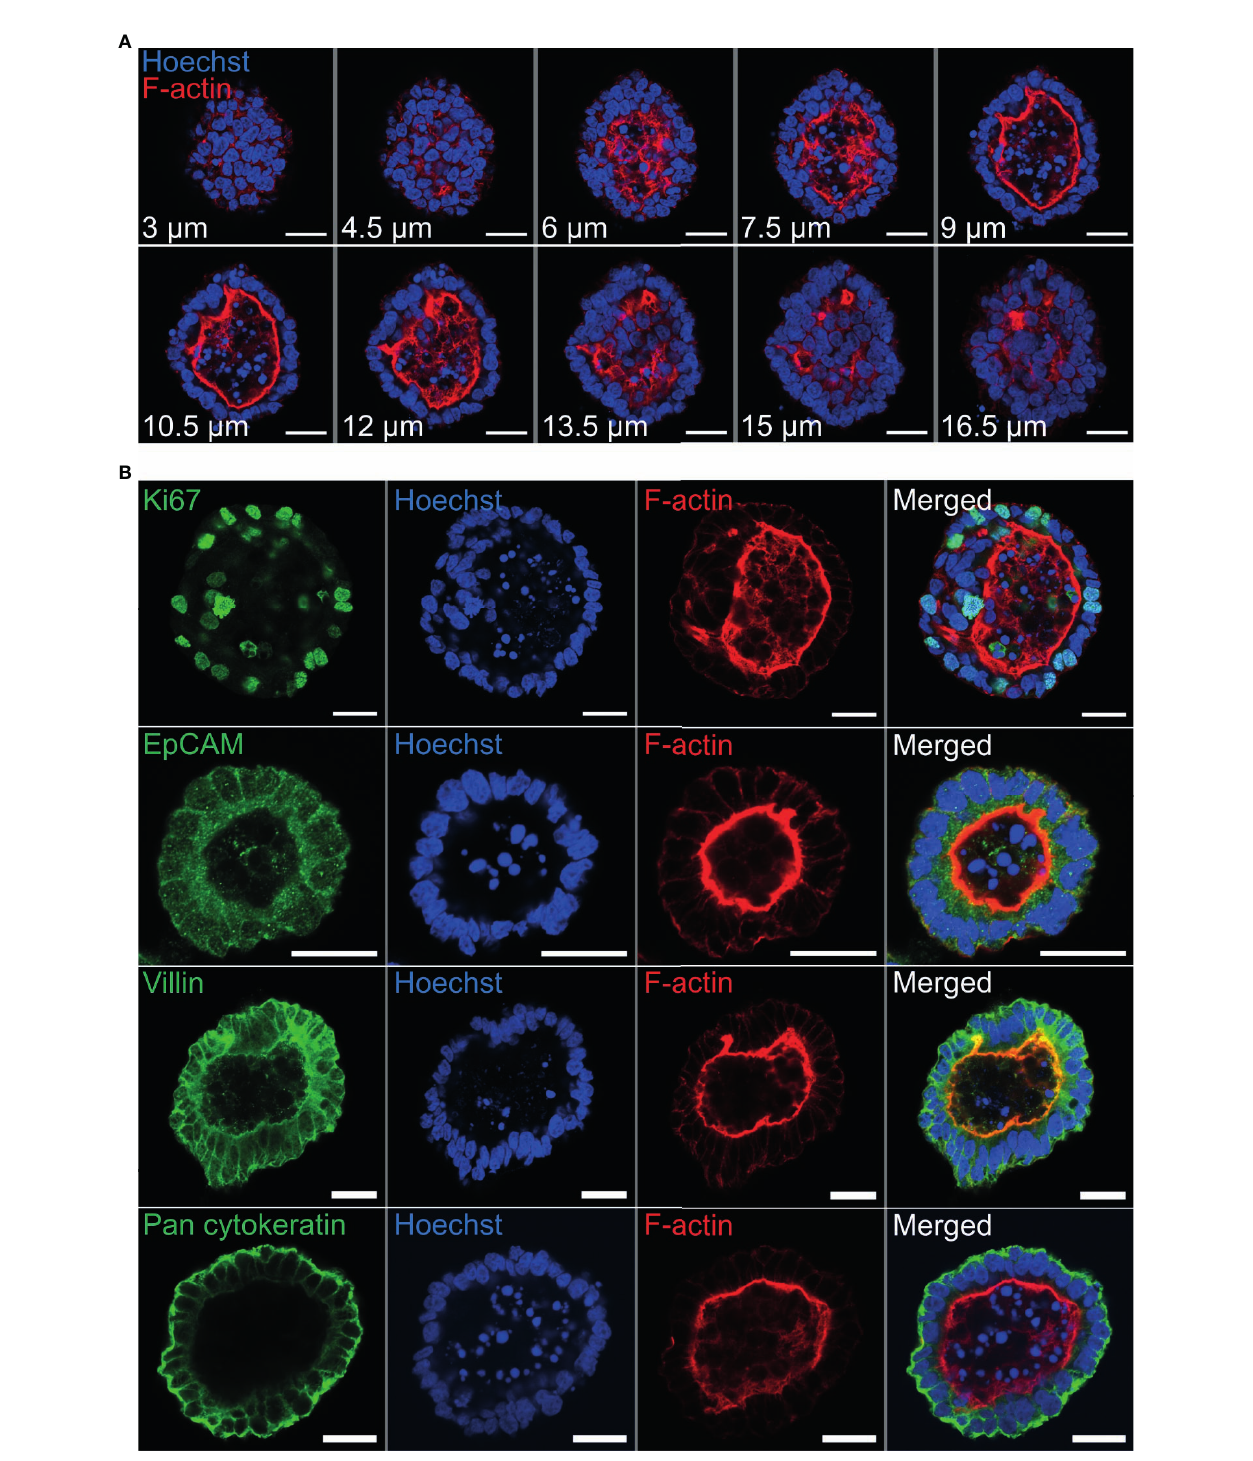
FIGURE 3 | Characterisation of ovine abomasum organoids by immuno fl uorescence confocal microscopy at seven days of in vitro culture. (A) Representative Z-stack images of an individual abomasum organoid with a closed luminal space and an internal F-actin-expressing brush border. Red = F-actin and blue = Hoechst (nuclei). (B) Representative images of abomasum organoids probed for either the cell proliferation marker Ki67, or the epithelial cell markers EpCAM, villin and pan-cytokeratin (all green). F-actin (red) and Hoechst (blue). Scale bars = 10